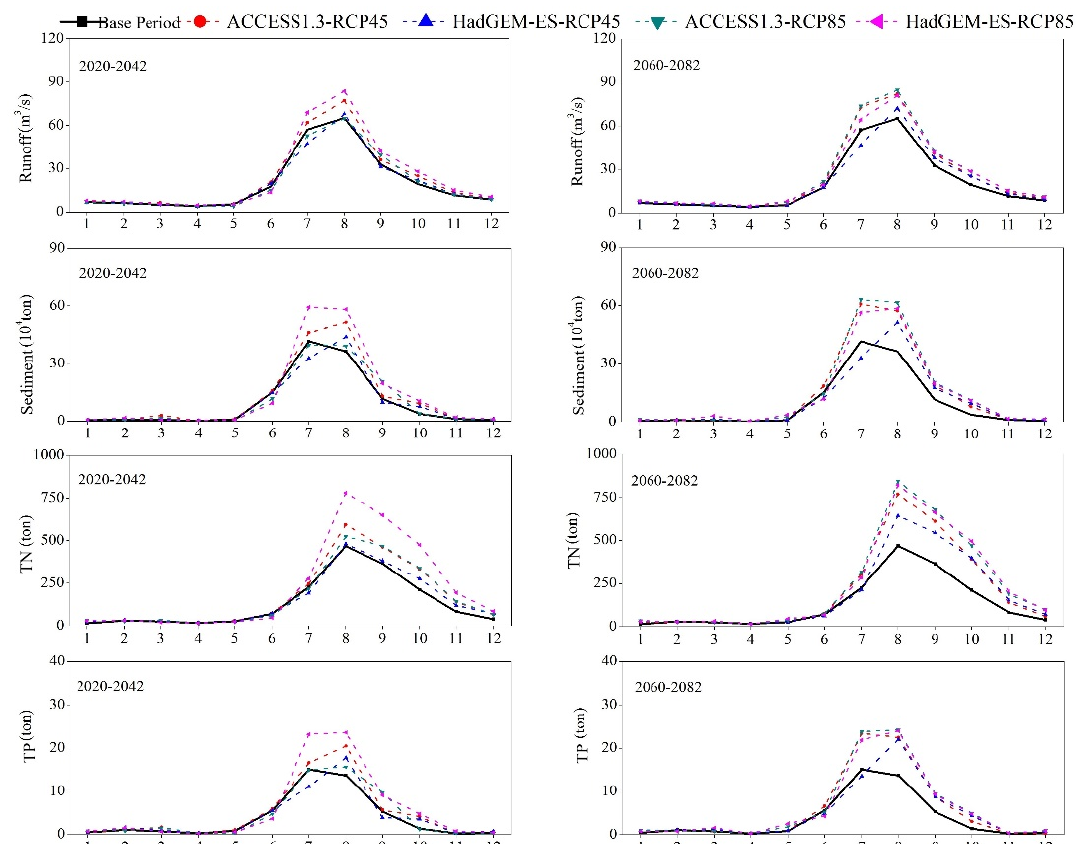
Figure 13. Comparison of average monthly streamflow, sediment, total nitrogen and total phosphorus under different climate change projection.